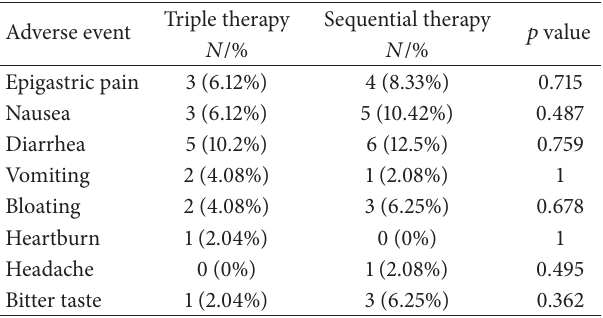
Table 3: Patients with self-reported adverse events during